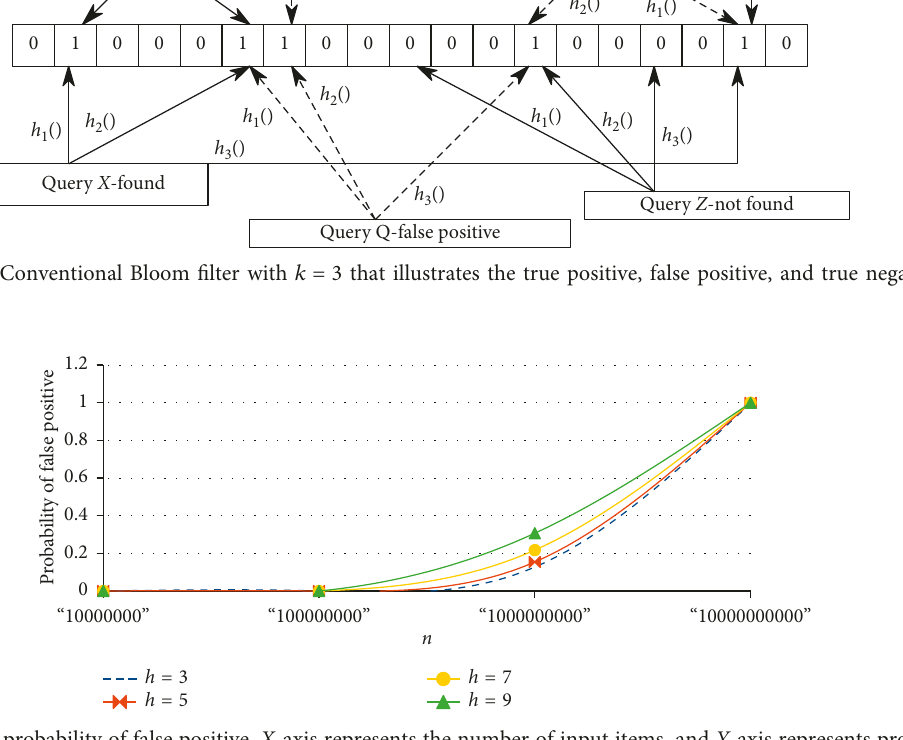
Figure 4: Theoretical probability of false positive. X -axis represents the number of input items, and Y -axis represents probability of false positive in m 2 32 memory size. (cid:31)